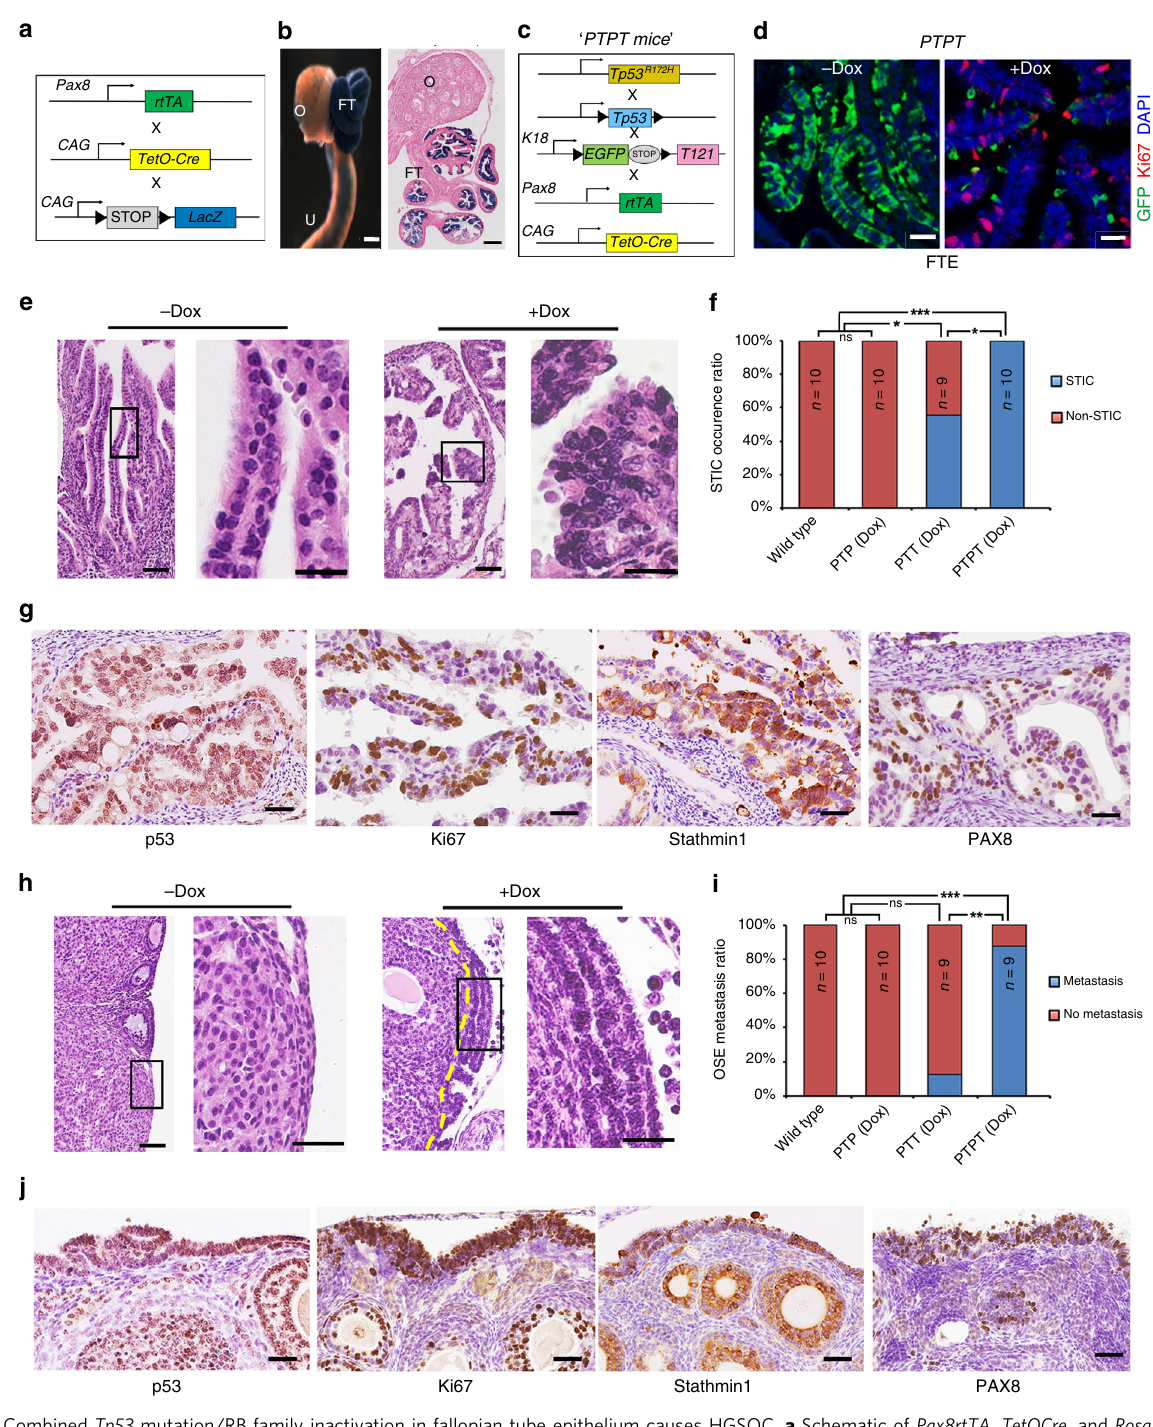
Fig. 1 Combined Tp53 mutation/RB family inactivation in fallopian tube epithelium causes HGSOC. a Schematic of Pax8rtTA , TetOCre , and Rosa26-lacZ alleles. b Whole mount (left panel) and 10×-magni fi ed histological section (right panel) of genital tracts of Pax8rtTA ; TetOCre ; Rosa26-LacZ female mice, treated with Dox (2 mg/ml in drinking water for 2 weeks), followed by X-gal staining and eosin counterstaining. Scale bar: 100 μ m c Schematic of Pax8rtTA; TetOcre;Tp53 R172H/- ;T121 (PTPT) mice. d Immuno fl uorescence staining for GFP (marker for keratin 18 + FTE cells, green), Ki67 (proliferation marker, red) and DAPI (nuclear stain, blue), with or without Dox treatment, as in b . Scale bar: 10 μ m. e Representative H&E-stained section of fallopian tube from PTPT mice collected 1 month after completion of Dox treatment (2 mg/ml in drinking water for 2 weeks). Boxed regions in left panels are magni fi ed in the right panel of each pair. Scale bar: 50 μ m. f % mice of each genotype with STIC, assessed 1 month after completion of Dox treatment, as above. g IHC for STIC markers in representative FTE sections of FTE from PTPL mice. Scale bar:10 μ m. h Representative H&E-stained section from PTPT ovaries, assessed 1 month after completion of Dox treatment as above or in mice left untreated for the same time interval. Boxed regions in left panels are magni fi ed in the right panel of each pair. Yellow line indicates the border between OSE and underlying cells. Scale bar: 50 μ m. i % of mice of each genotype with ovarian metastasis (assessed as in h ). j IHC for HGSOC markers in representative ovary sections from PTPL mice. Scale bar: 10 μ m. ns, not signi fi cant. * P < 0.05, ** P < 0.01,*** P < 0.001, Fischer ’ s exact